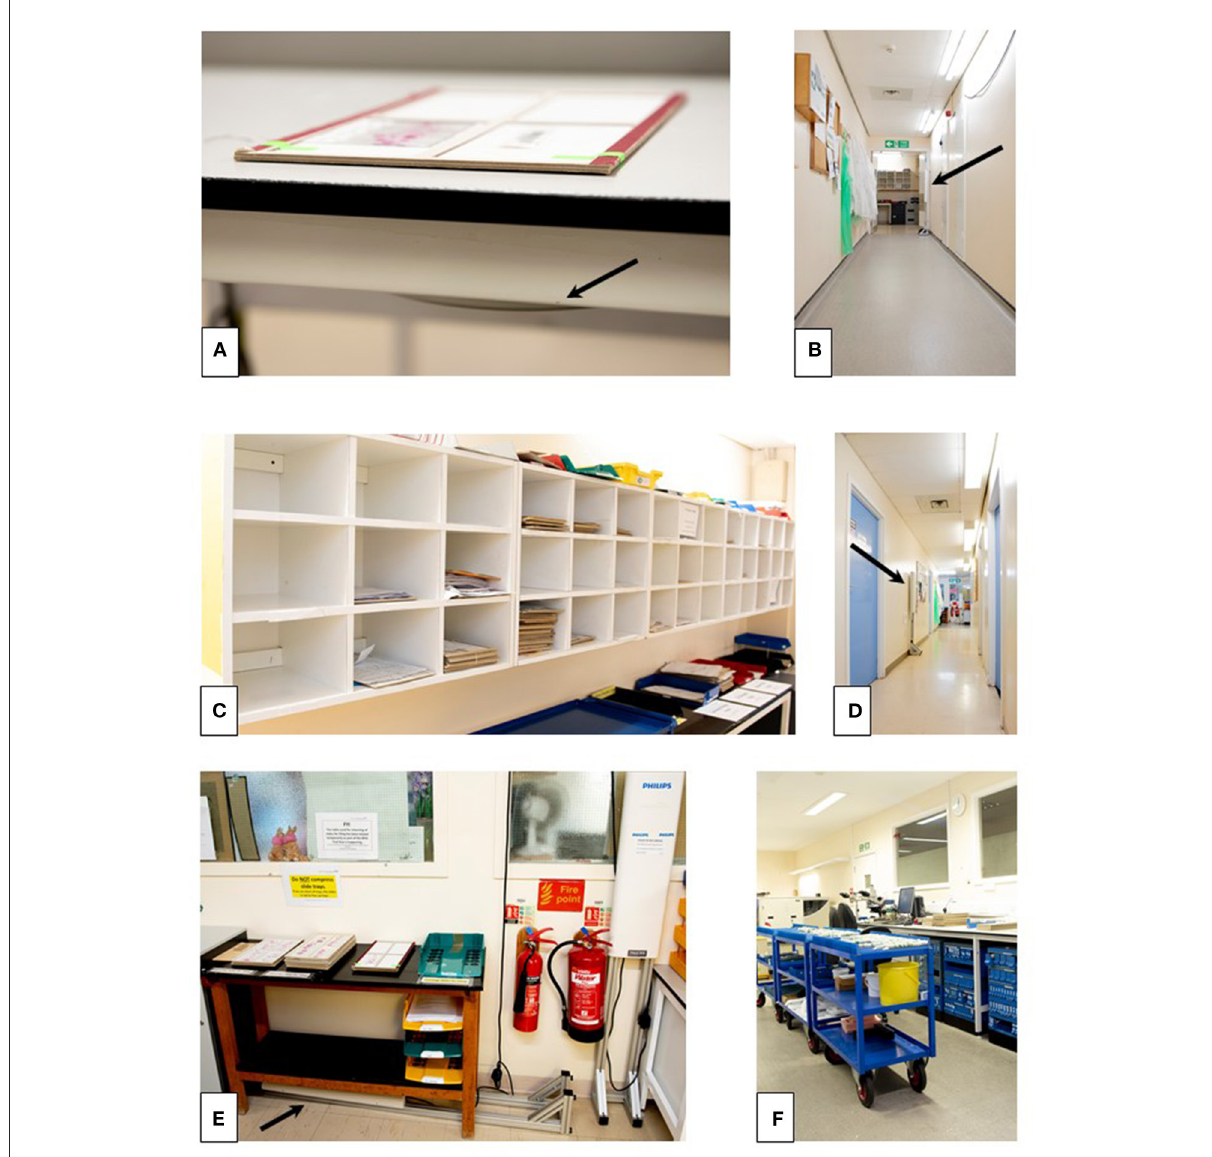
FIGURE3 The “real-life” analog laboratory workflow which will effectively disappear with the transition to digital pathology. The cases leave the lab from the sign out bench (A) in batches, passing through the doors at the end of the lab (PH doors, B , see also Figure 2D) to be distributed into the PH (C) for collection by pathologists. Pathologists transport cases back to their workstations (offices) for review and reporting (D) , and then batch the cases prior to returning them to the filing bench (filing pile, E ) from where they are collected several times daily and taken for filing at the “filing final” bench back in the laboratory (F) . The position of RFID readers in the images is indicated by the arrows. PH, pigeon